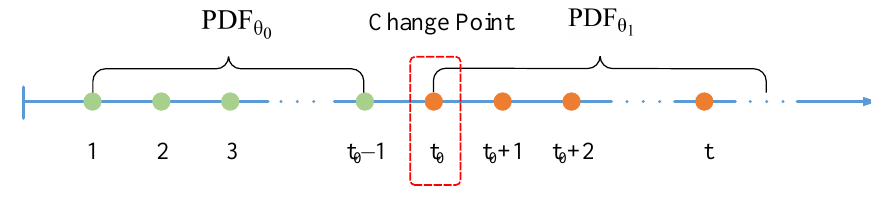
Figure 3. A single change point